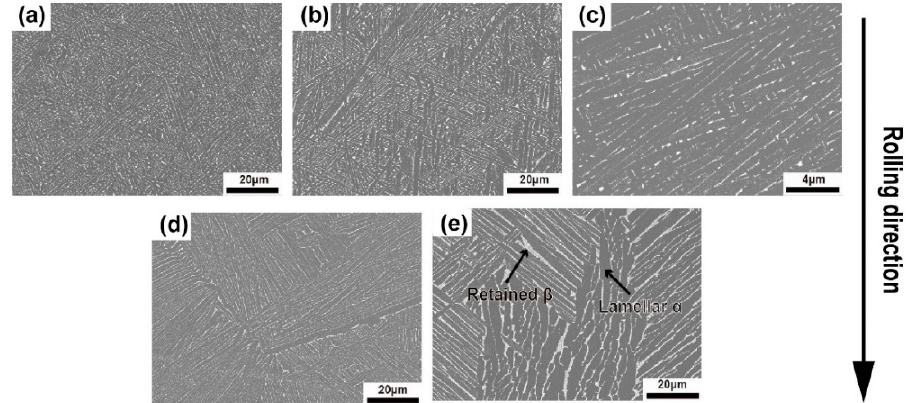
Figure 4. Backscattered scanning-electron-microscope (SEM) images of TC4F after treatment. Samples ( a ) 1, ( b ) 2, ( c ) 3, ( d ) 4, and ( e ) 5. Dark lamellar areas, α phase; light ones, β phase.